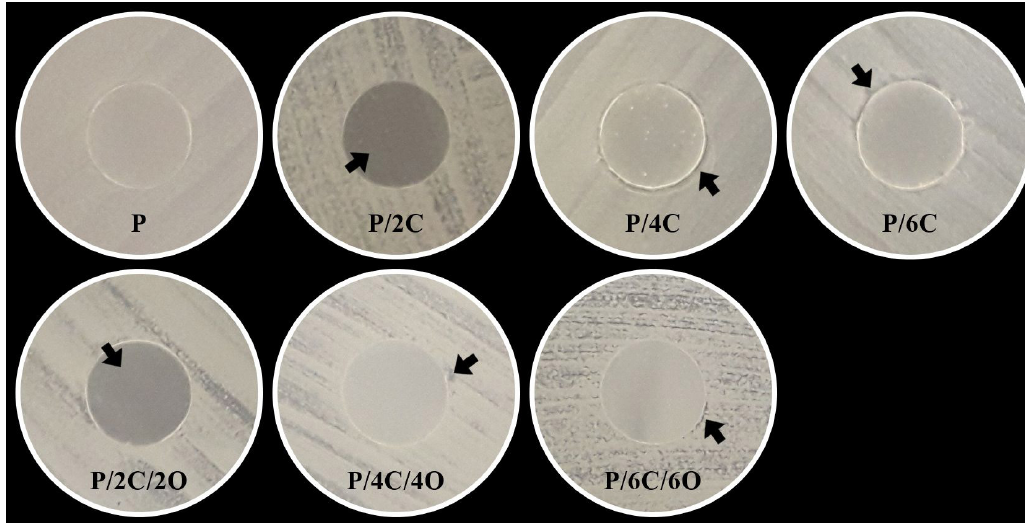
Figure 6. Antimicrobial activity of the films evaluated by the agar diffusion method against S. aureus